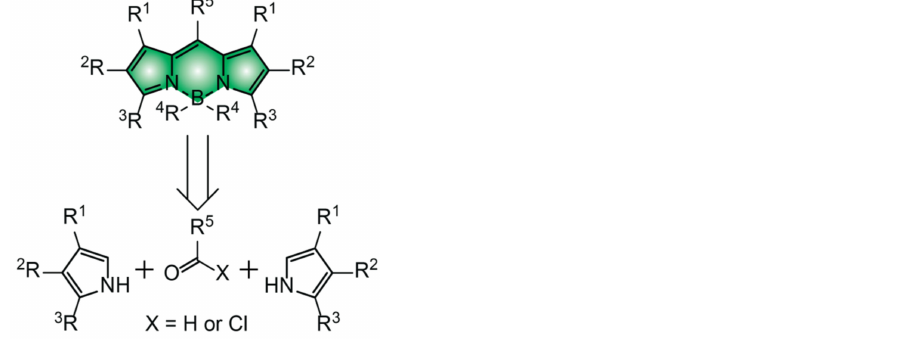
Figure 5. Molecular skeleton of the BODIPY chromophore together with its retrosynthetic